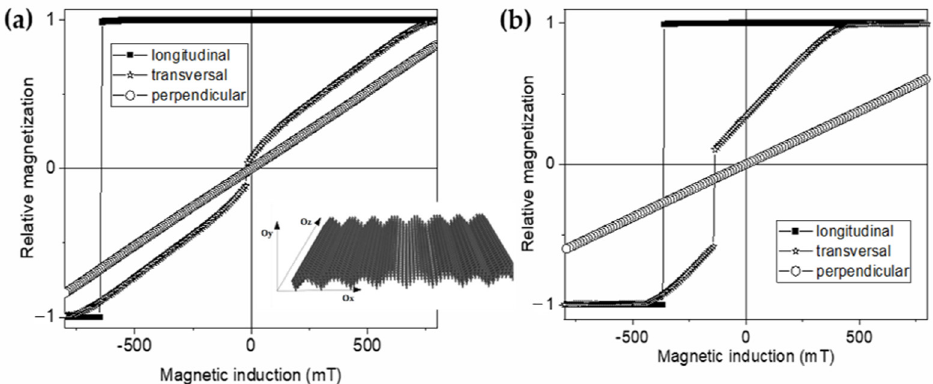
Figure 2. The magnetization reversal of an undulated Fe thin film with a thickness of 3 nm, deep of the valley of 5 nm, and lateral periodicity of 15 nm, in case of three specific directions of the applied magnetic field. The considered geometry with the associated reference system used in the computations is shown in the inset ( a ). The magnetization reversal of an undulated Fe thin film with a thickness of 3 nm, deep of the valley of 3 nm, and lateral periodicity of 15 nm, for the same three specific measurement geometries ( b ).